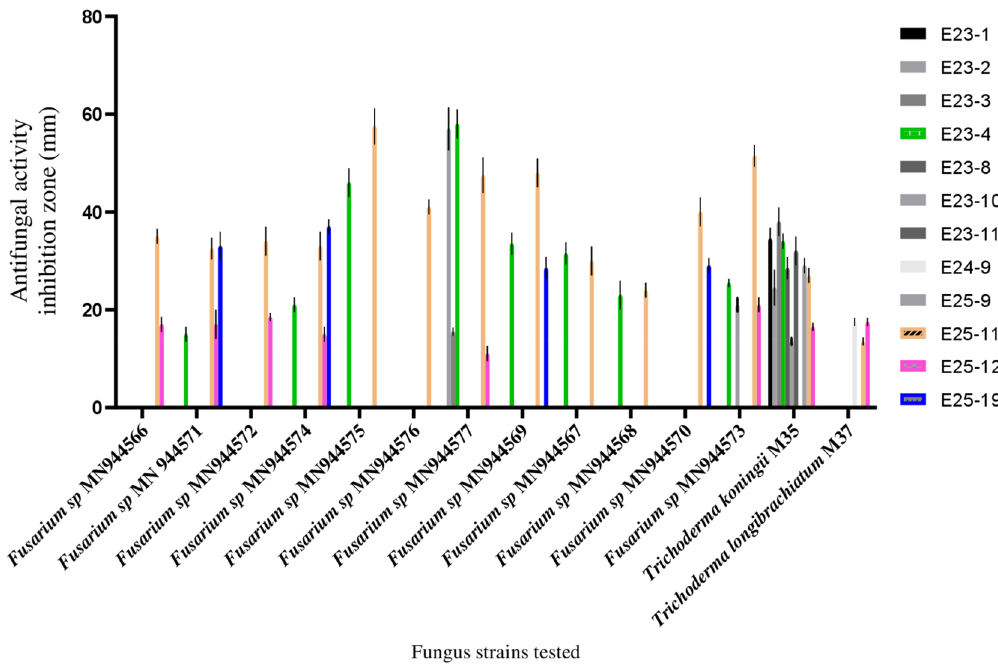
Figure 4. Primary screening (antifungal activity) by the double layer method on ISP2 medium against phytopathogenic